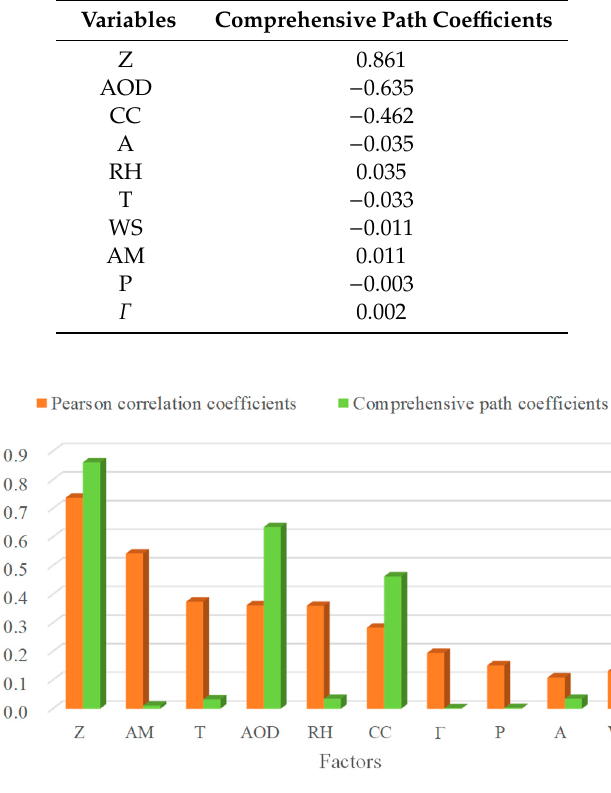
Figure 5. Histogram of absolute values of r and comprehensive path coefficients of 10 factors to GHI.